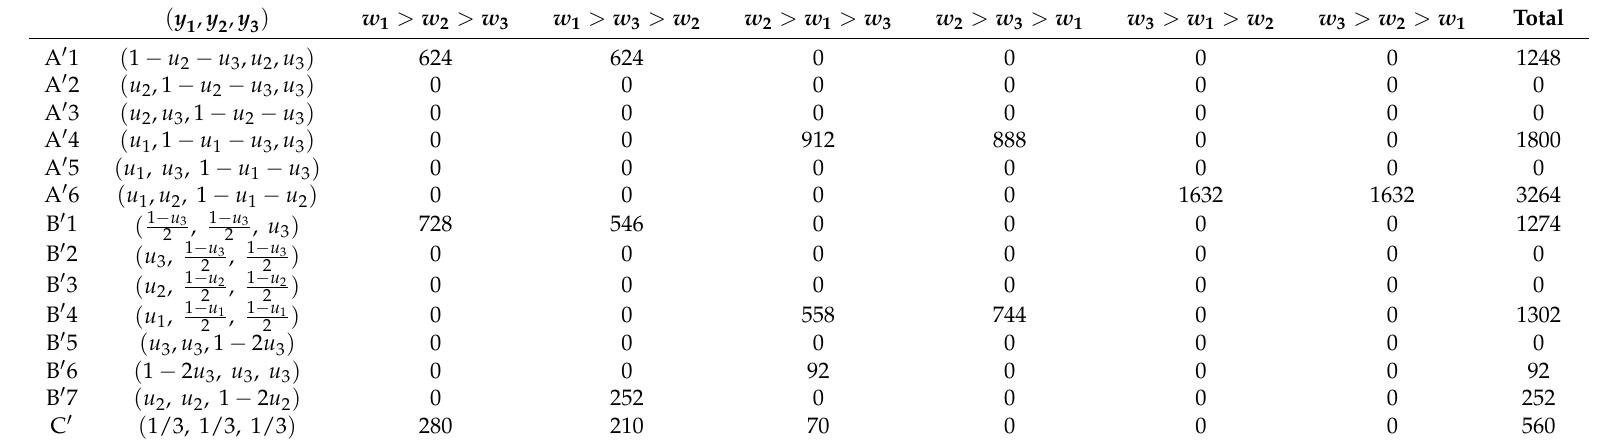
Table 6. The number of instances satisfying solution type and weight for 3COWAU with − 1 ≤ u 3 ≤ u 2 ≤ u 1 ≤ 1.